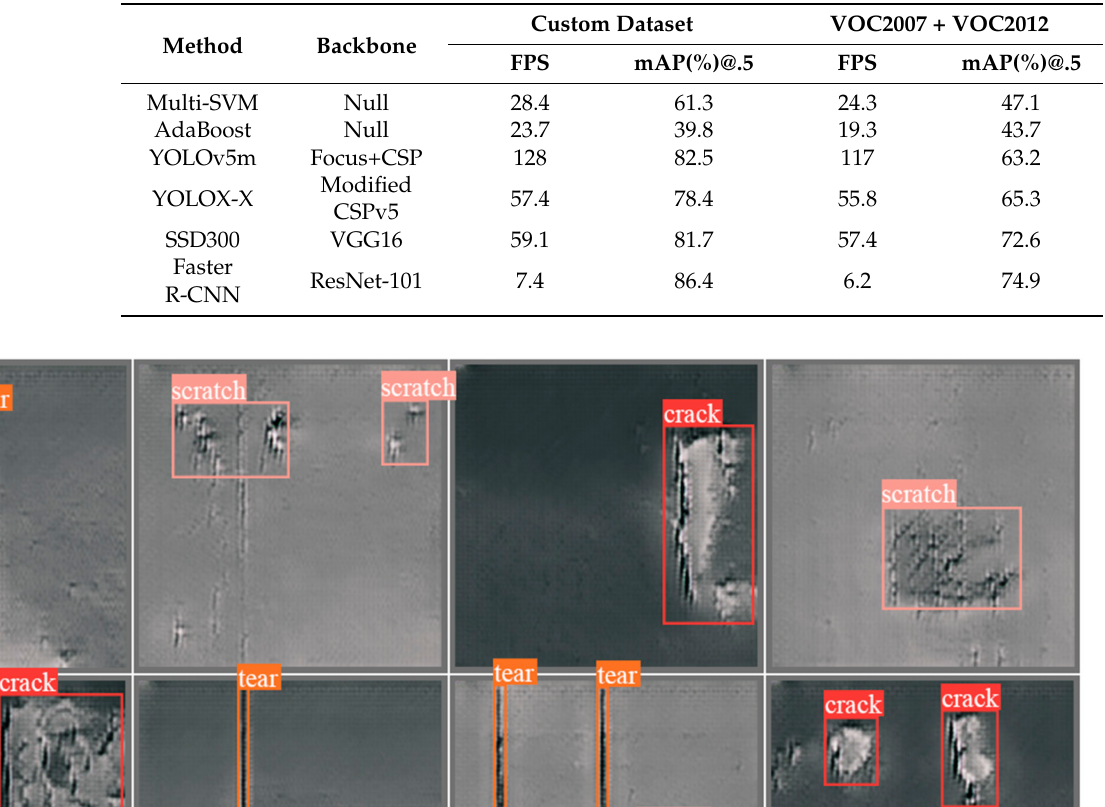
Table 5. Experimental results on custom belt damage dataset and public datasets in which the score threshold is set to 0.5, image resolution of the custom dataset is 416x416 and the GPU is NVIDIA RTX 2080s. For public datasets, models were trained on VOC2007 and VOC2012 training datasets tested on the VOC2007 testing dataset.